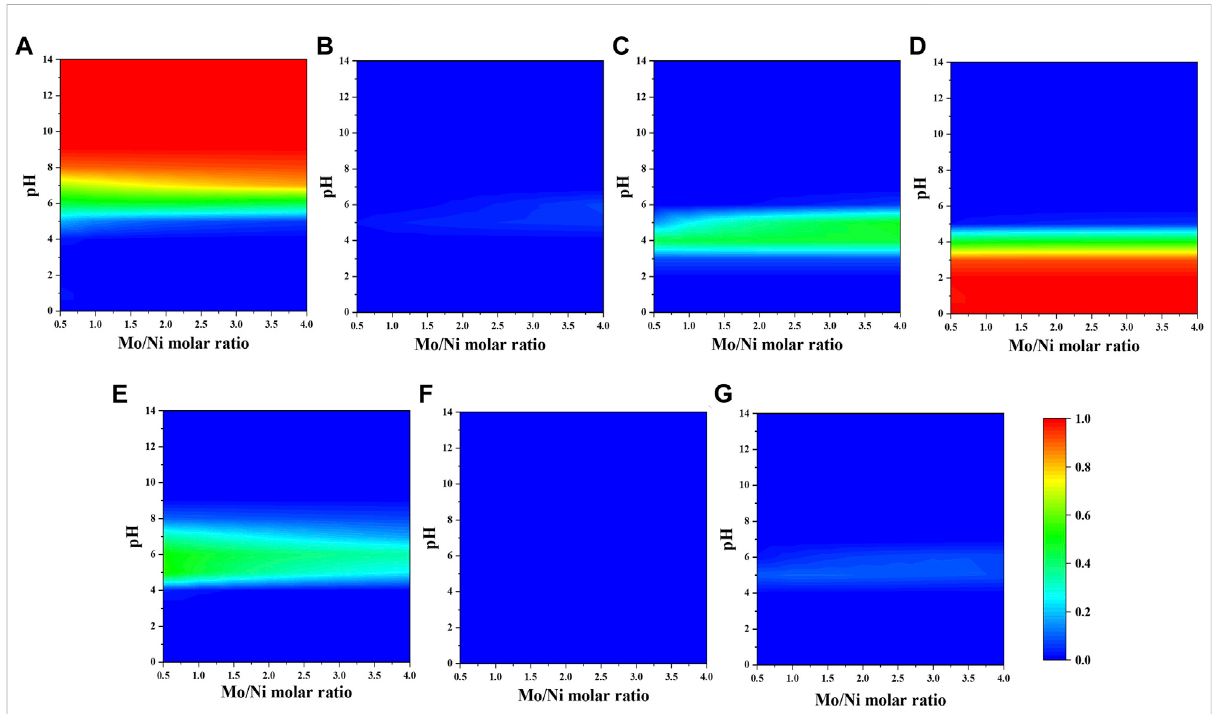
FIGURE 2 Fractionofmolybdenum-citrateandnickel – molybdenumcomplexes (A) MoO 4 2- , (B) M 7 O 24 6- , (C) HMO 7 O 24 5- , (D) H 2 Mo 7 O 24 4- , (E) MoO 4 HCit 4- , (F)